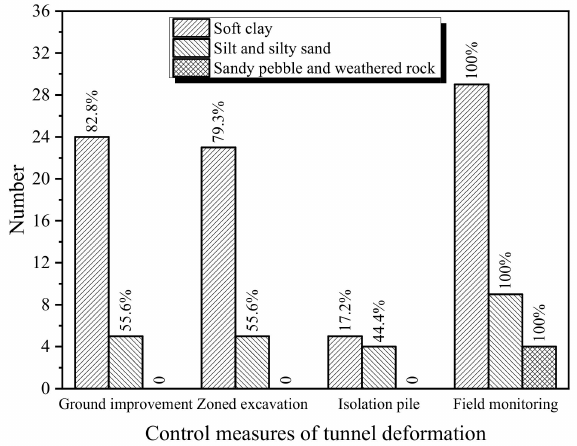
Figure 8. Control measures of tunnel displacement under different soil